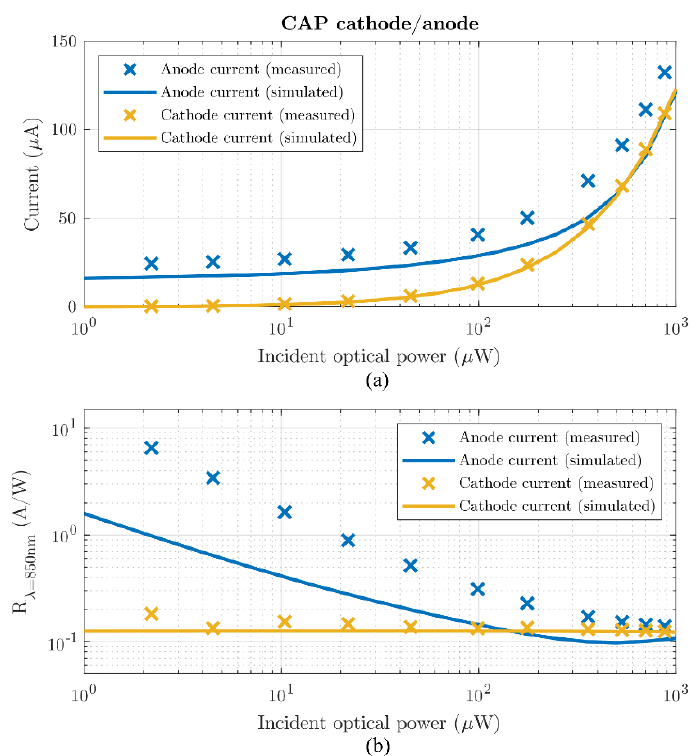
Figure 8. Measured and simulated anode and cathode current ( a ) and responsivity ( b ). V anode = V cathode = 0 V, V ring = V substrate = −5 V.